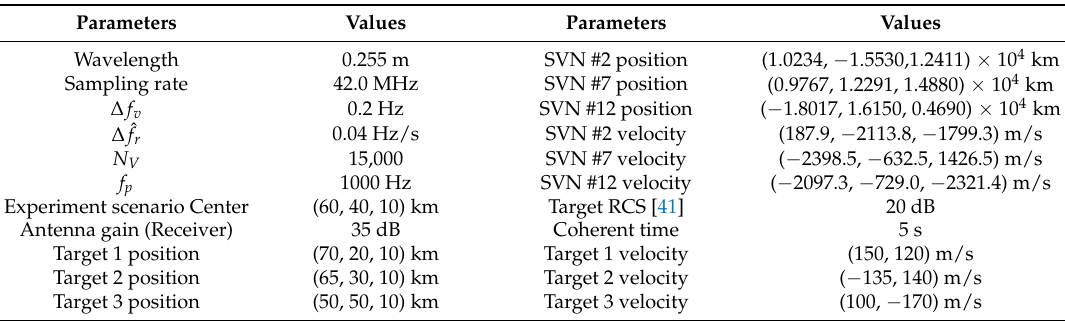
Table 1. Main simulation